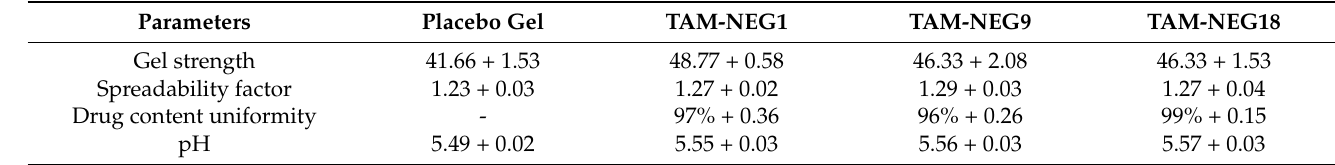
Table 6. Characterisation of the placebo gel and TAM-